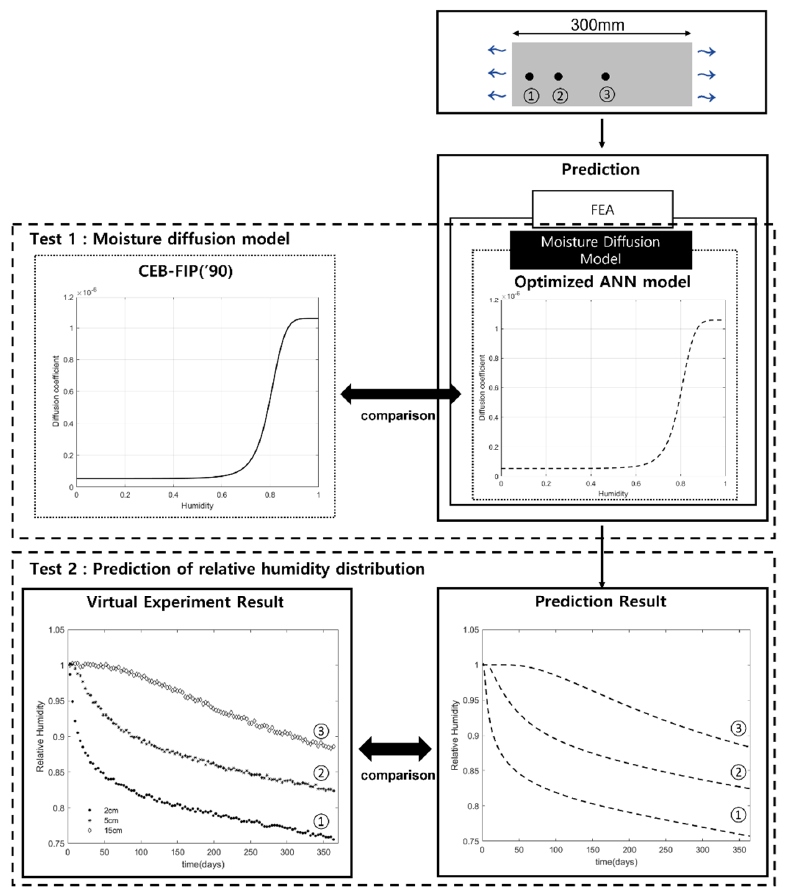
Figure 9. The schematic flow of the performance test.